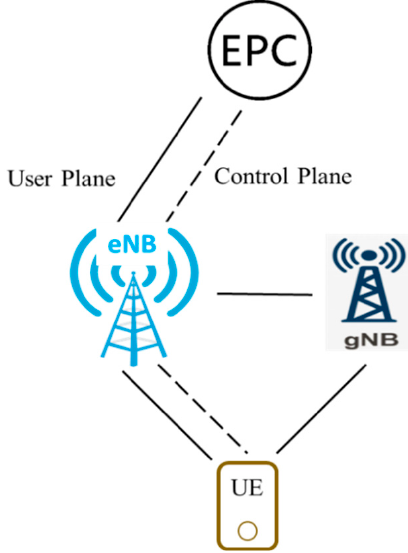
Figure 3. Option 3 of the NSA networking mode.